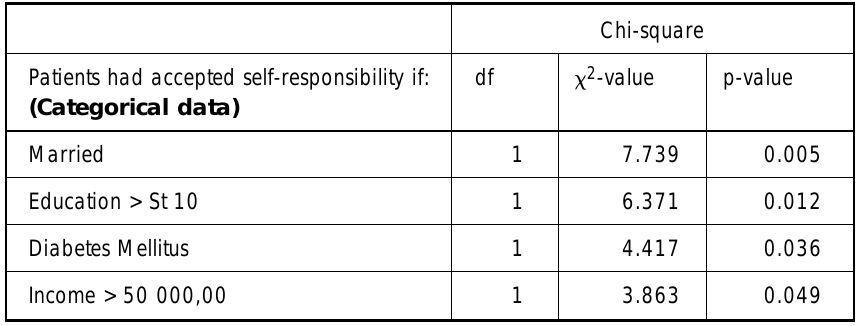
Table V11: Self-Responsibility - On Admission into the trial.